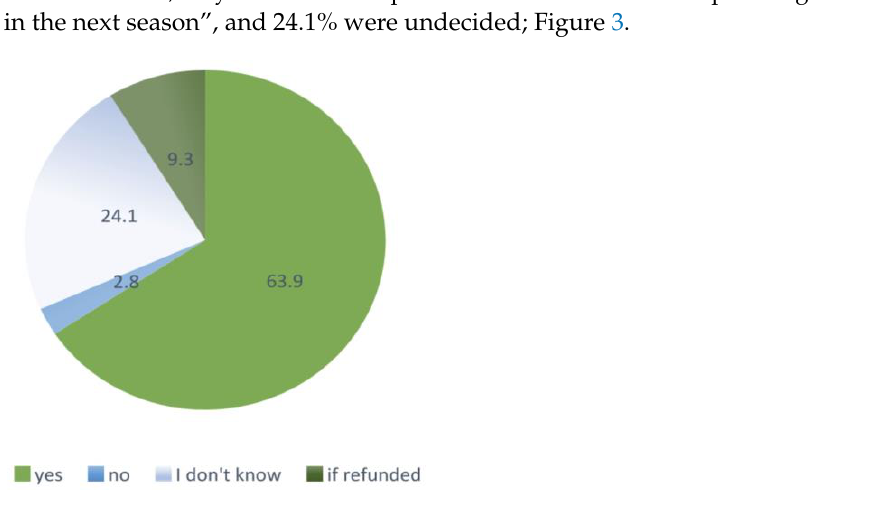
Figure 3. Intentions to vaccinate against influenza in the next epidemic season (2019/2020); Gryfino, Poland ( n = 108).